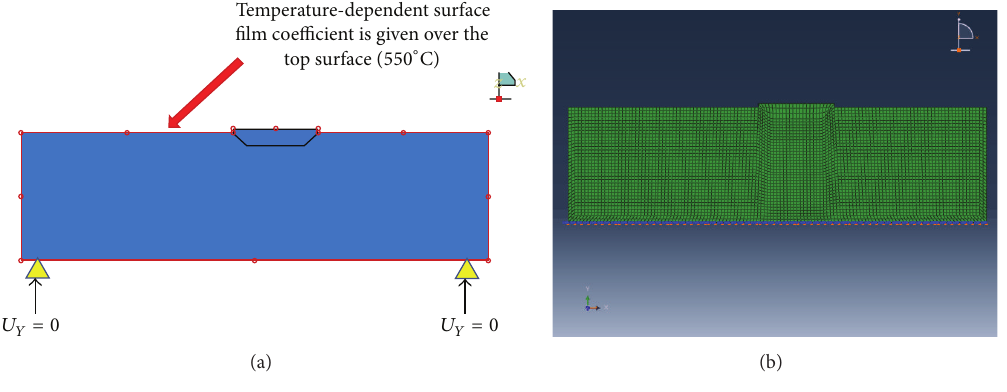
Figure 4: (a) Boundary conditions. (b) Meshed